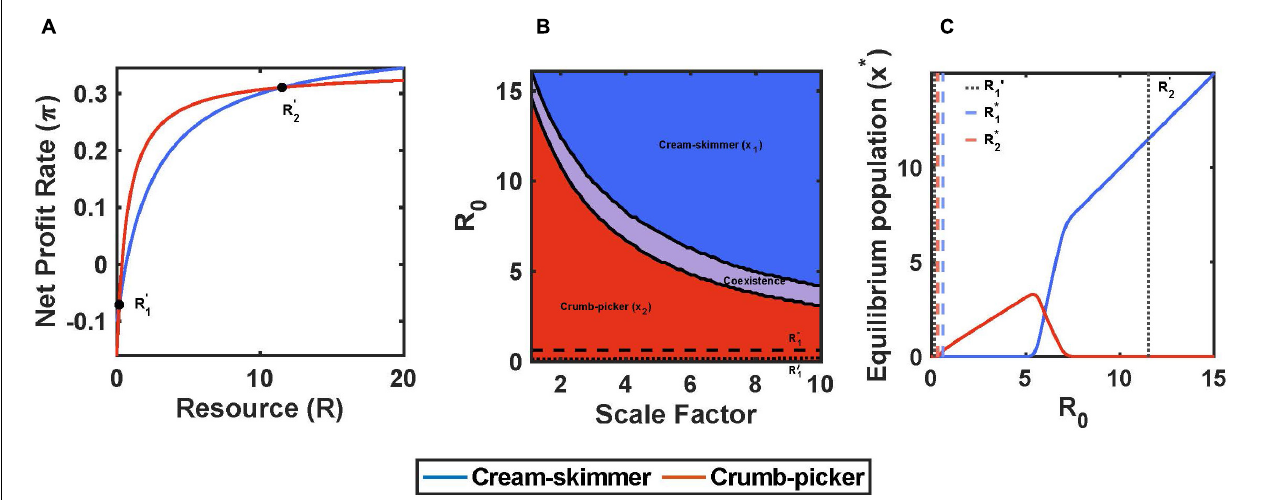
FIGURE 4 | Encounter rate and cost of existence trade-off with pulsed resource, h 1 = h 2 = 2. (A) The crumb-picker has the higher net profit rate than the cream-skimmer for R (cid:48) 1 < R < R (cid:48) 2 . (B) Regions of competitive exclusion and coexistence change due to initial pulse size R 0 and the scale factor µ . (C) For µ = 5, equilibrium populations change as a function of R 0 . Intermediate values of R 0 show species coexistence. Parameters: µ = 5, a 1 = 0.2, a 2 = 0.1 µ + a 1 , c 1 = 0.1, c 2 = 0.012 µ + c 1 , b 1 = b 2 = 0.5, T = 10, R 0 = 10, x 1 (0) = 10, x 2 (0) =